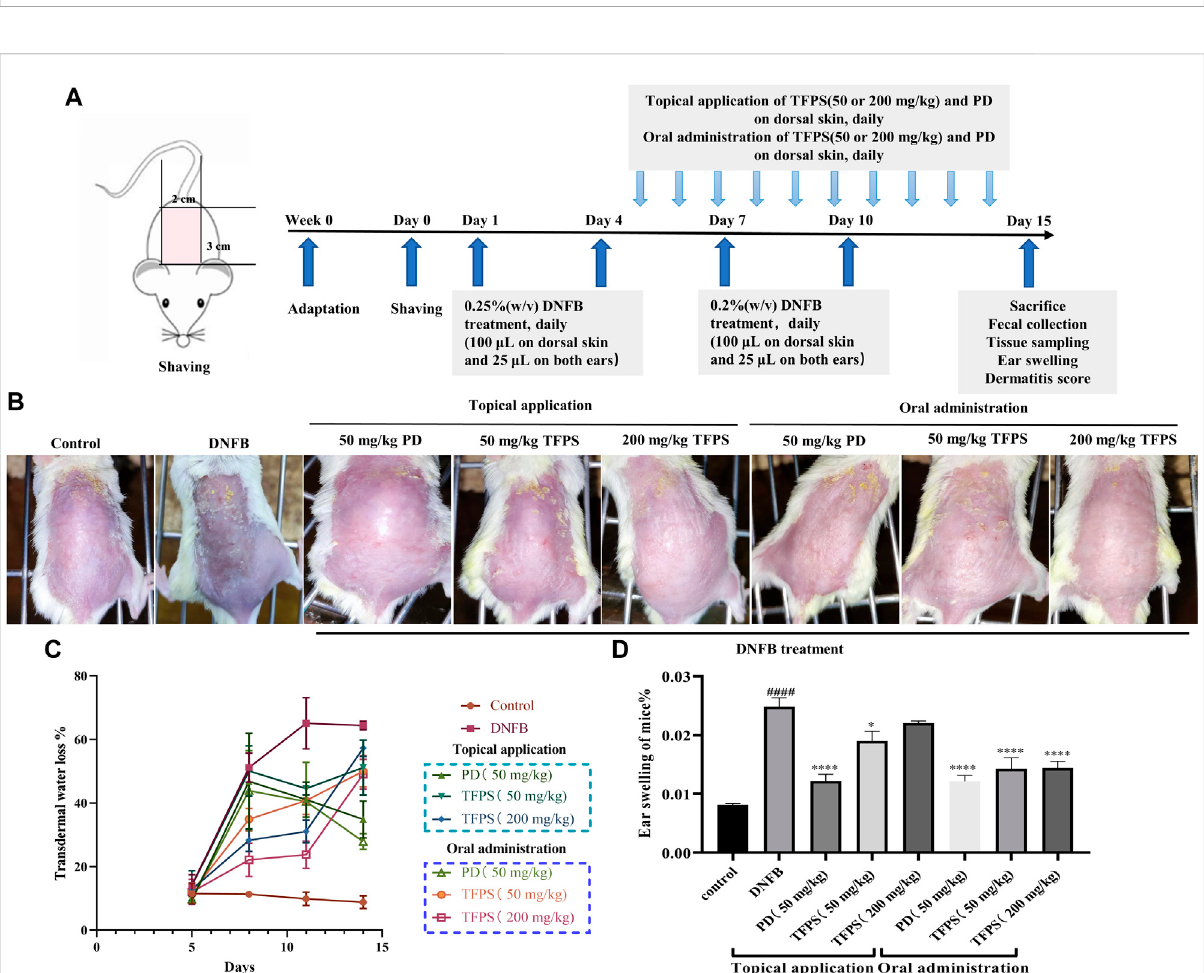
FIGURE 2 Improvement of AD-like symptoms by TFPS treatment in a murine AD model. (A) In vivo experimental schedule is shown. Babl/c mice were dividedintoeightgroups:normalcontrol(Controlgroup),DNFB+PBS(DNFBgroup),50 mg/kgPDgroup(includingtopicalororaladministrationof PD), 50 mg/kg TFPS treatment group (including topical or oral administration of TFPS) and 200 mg/kg TFPS treatment group (including topical or oral administration of TFPS). To study the effect of TFPS on atopic dermatitis, mice were treated with DNFB on day 1, day 4, day 7, and day 10, then topical or oral administration of TFPS for 10 days after the DNFB treatment. (B) The mouse taken on the 14th day is rephotographed. (C) The TEWL was tested by electrolyzed water analysis on day5, day8, day 11, and day14. (D) Animalswere culled and animal ears were removed for punch weighing on day 15. All values are presented as means ± S.E.M (n = 3). ### p < 0.001, compared with Control group. p p < 0.05, ppp p < 0.0001, compared with DNFB